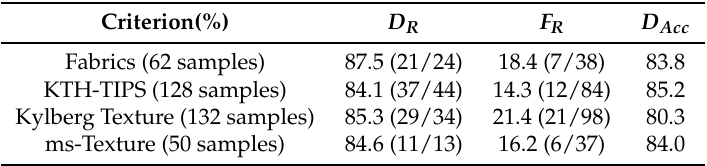
Table 2. Quantitative image-level defect detection results for the proposed MSCDAE model on the Fabrics, KTH-TIPS, Kylberg Texture and ms-Texture